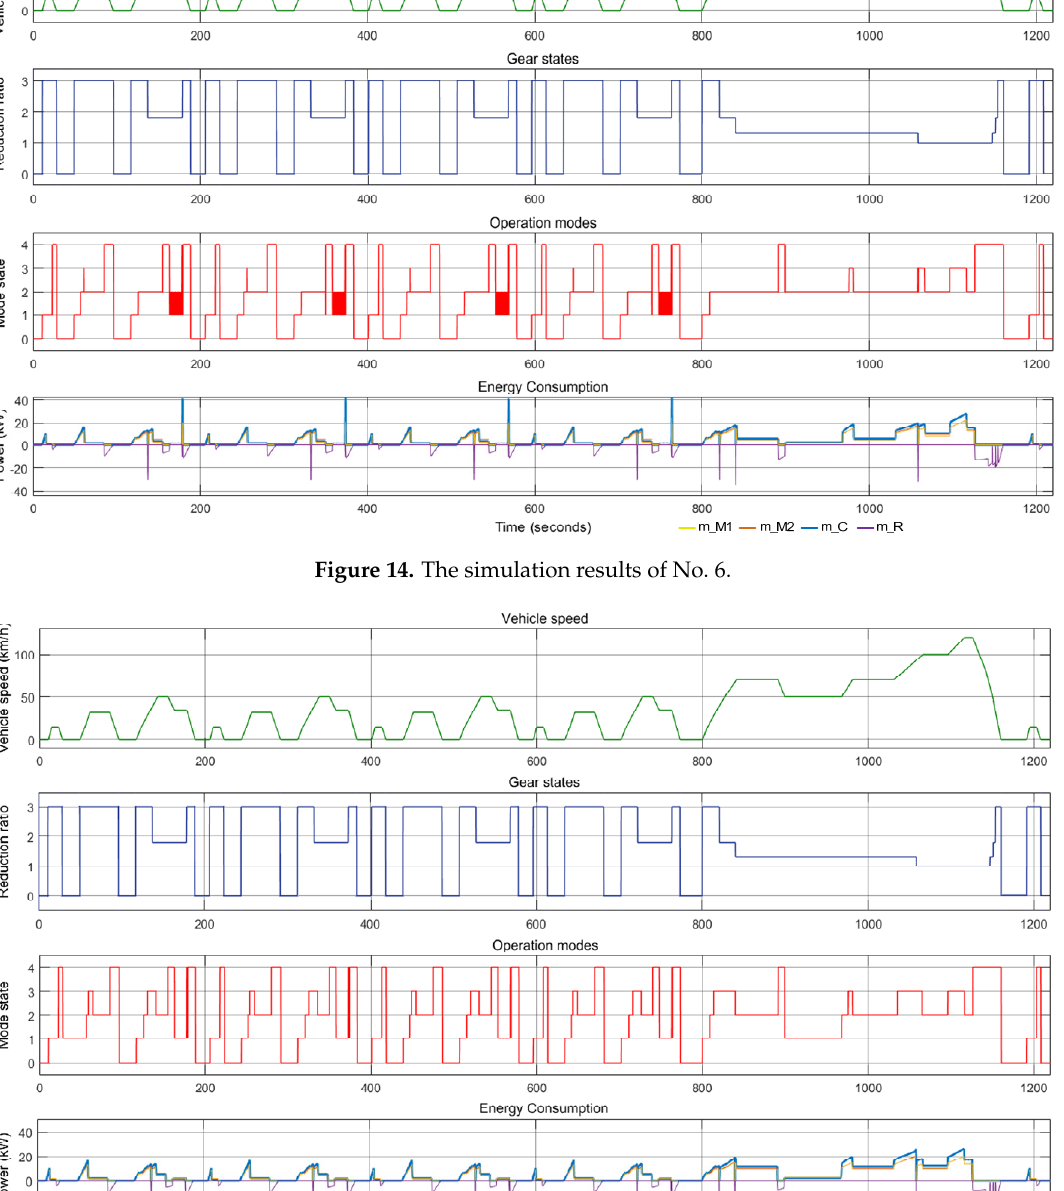
Table 3. The comparison No. 6 and No. 7 for the operation mode selection.